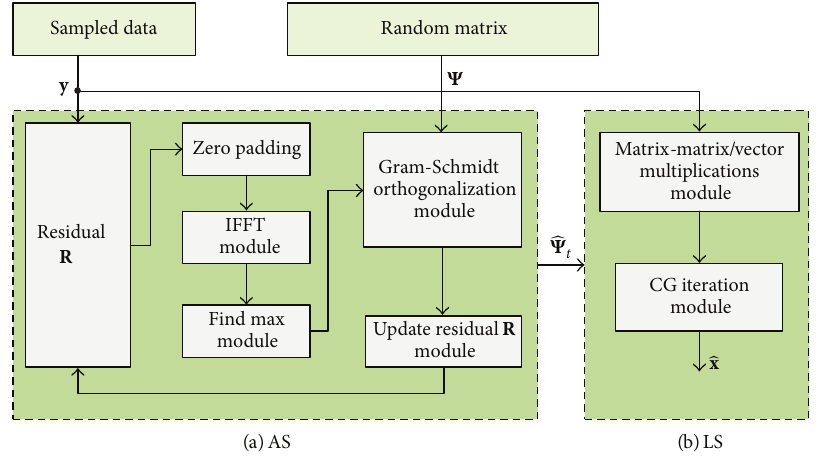
Figure 2: Detailed architecture diagram of top-level design.